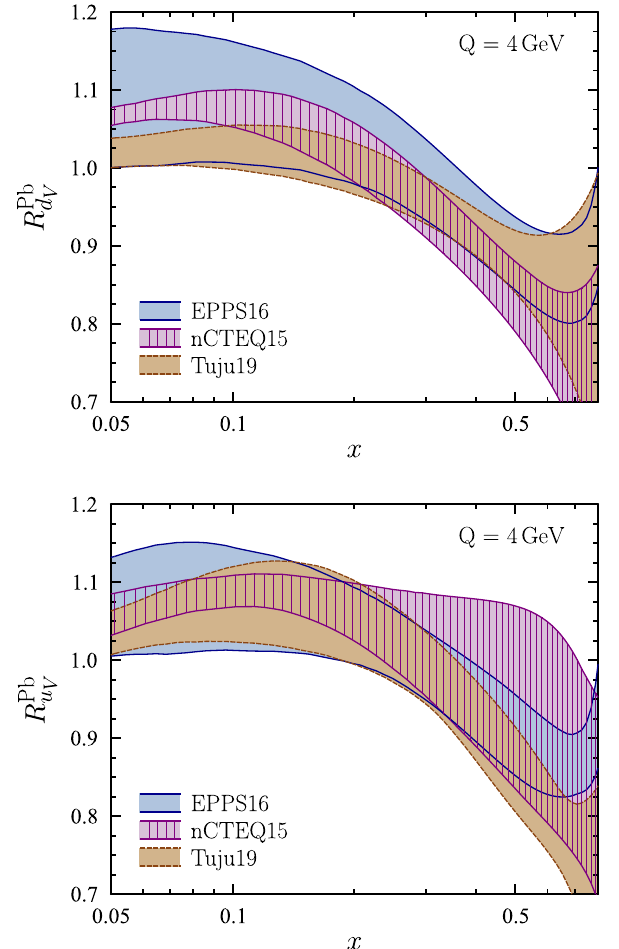
Fig. 1 Comparison of the valence-quark nuclear modifications as encoded in the EPPS16 (blue bands), nCTEQ15 (purple bands with hatching) and TuJu19 (brown bands) parametrizations at Q = 4GeV